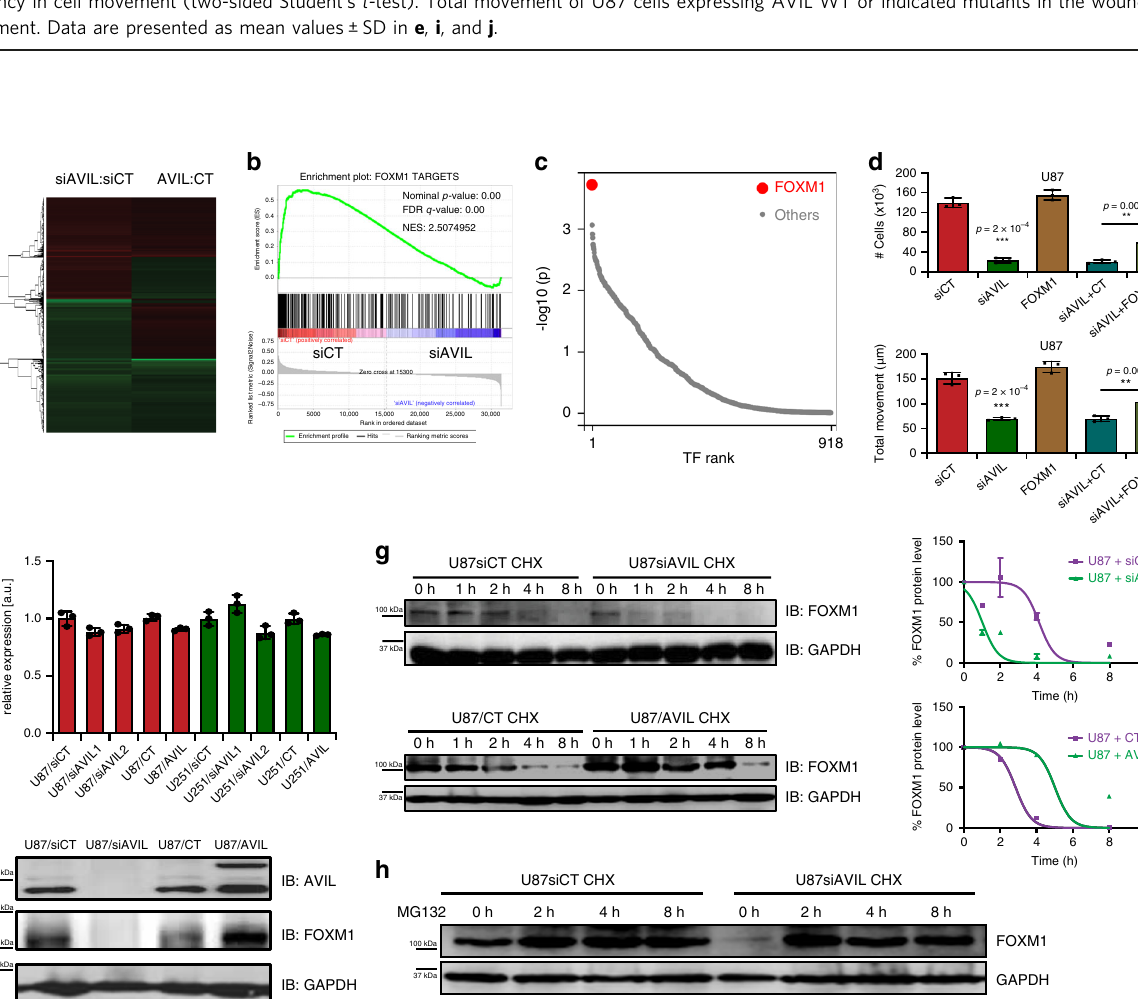
Fig. 7 AVIL regulates the stability of FOXM1. a Whole transcriptome analyses of U87 cells transfected with siAVIL vs. siCT, and stable AVIL overexpression cells vs. empty vector control (CT). b Gene Set Enrichment Analysis revealed highly similar pro fi les between FOXM1 targets, and differentially expressed genes caused by AVIL silencing and overexpression. NES score = 2.5. c BART prediction ranked FOXM1 as the top factor. d FOXM1 expression can rescue at least some of the AVIL effect. U87 cells transfected with siAVIL or siCT were further transfected with FOXM1 expression vector, or control plasmid (CT). Cell proliferation was measured by cell counting. Cell motility was measured by wound-healing assay. e FOXM1 RNA expression was not affected by AVIL silencing or overexpression. qRT-PCR measuring FOXM1 mRNA level in U87 and U251 cells. FOXM1 RNA expression was normalized against that of GAPDH . No statistical signi fi cance (ns) was observed in all groups compared to CT or siCT. f FOXM1 protein was reduced upon AVIL silencing, and induced upon AVIL overexpression. Western blot measured the protein levels of AVIL, FOXM1, and GAPDH. Upper band in AVIL Western is GFP-tagged AVIL. g FOXM1 protein half-life was reduced upon AVIL silencing, and induced upon AVIL overexpression. U87 cells were treated with cycloheximide to inhibit new protein synthesis. FOXM1, and GAPDH proteins were measured by Western Blot analysis. Protein signals were quanti fi ed by densitometry. h The reduced half-life of FOXM1 can be offset by the proteasome inhibitor, MG132. Data are presented as mean values± SD in d , and e